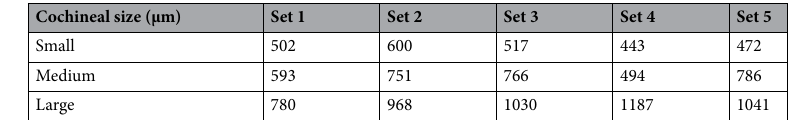
Table 1. Approximate cochineal sizes in microns used in each additional measurement of in-vivo fluorescence.